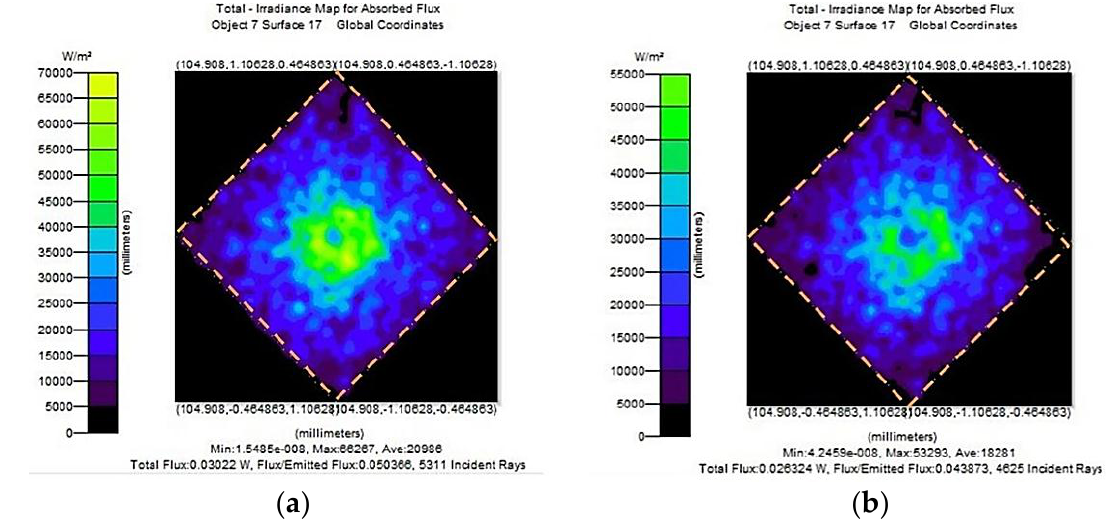
Figure 5. Initial simulation results ( a ) normal structure (2.0 Ø ); ( b ) with hollow disk (1.6 Ø ).